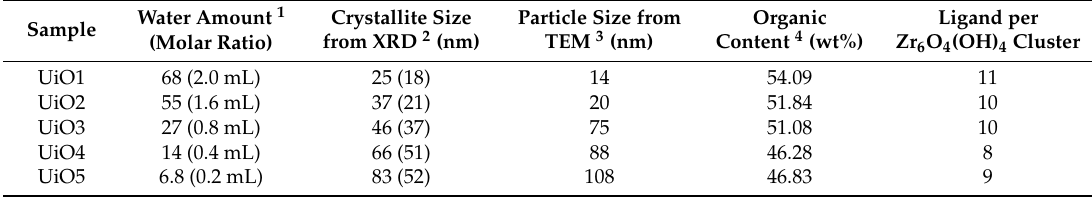
Table 1. Characteristics of UiO-66 nanoparticles.